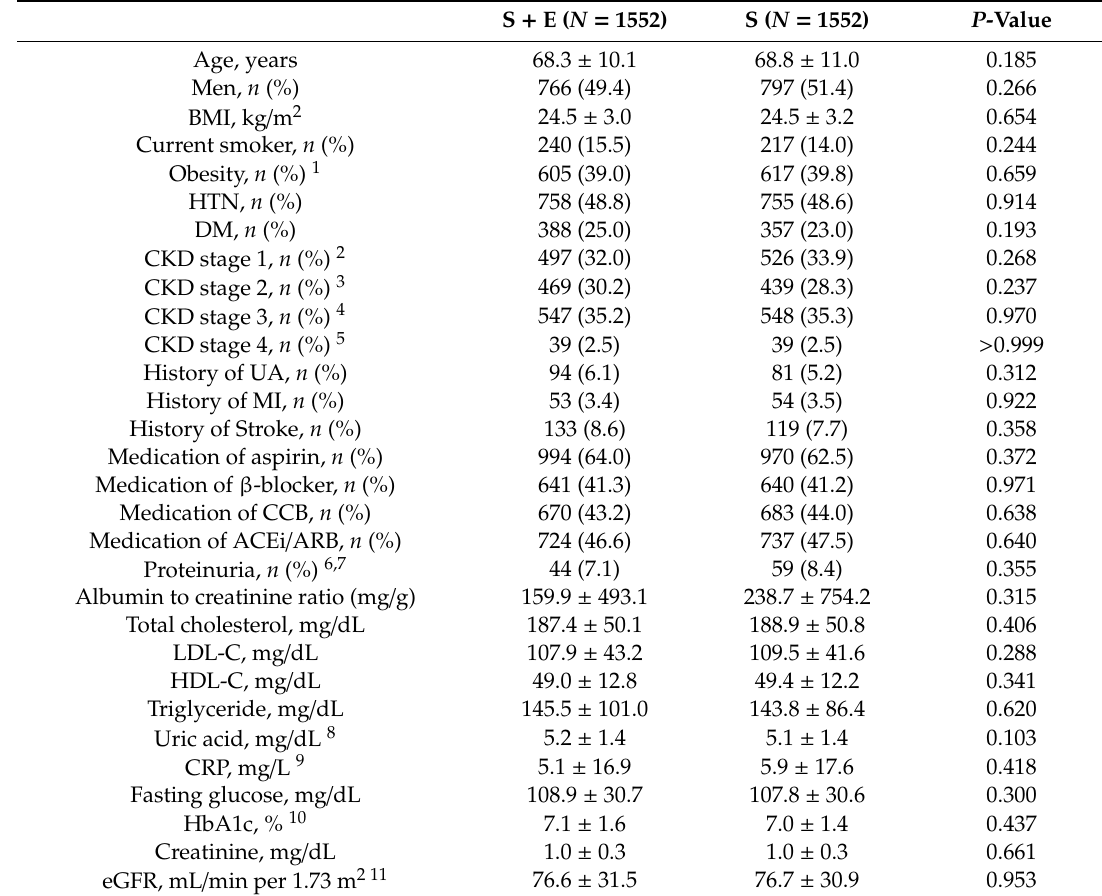
Table 1. Baseline characteristics by treatment group, after propensity-score